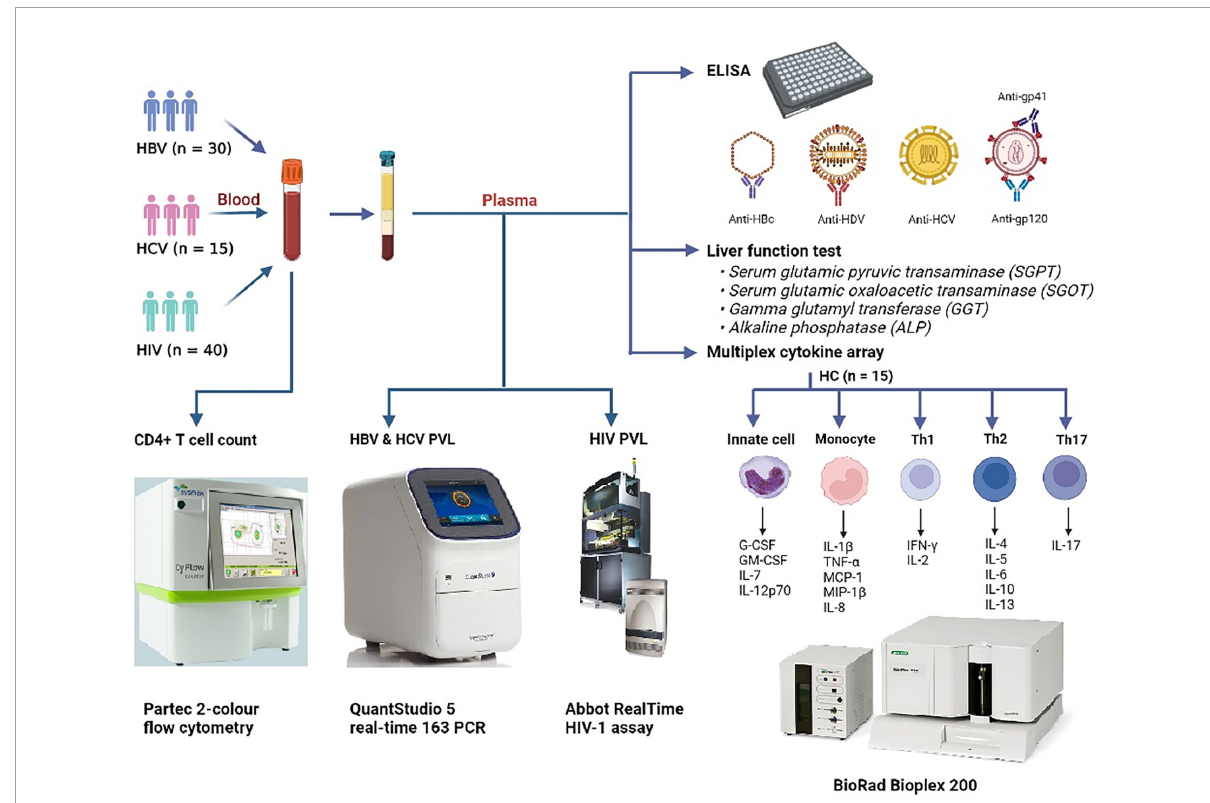
FIGURE1 Graphical outline of the study. Peripheral blood was collected from patients with HBV ( N = 30), HCV ( N = 15), and HIV ( N = 40) and were subjected to CD4+ T cell counts and HIV, HBV, and HCV viral load estimations. Anti-HBc IgG, anti-HDV IgM, anti-HCV, and anti-HIV-1/2 antibodies were screened by ELISA. Liver function test was performed to estimate the levels of SGPT, SGOT, GGT, and ALP in plasma. Plasma cytokine levels were determined by a commercial Bio-plex cytokine array. HBV, hepatitis B virus; HCV, hepatitis C virus; HDV, hepatitis delta virus; HIV, human immunodeficiency virus; HC, healthy control; SGOT, serum glutamic oxaloacetic transaminase; SGPT, serum glutamic-pyruvic transaminase; GGT, gamma-glutamyl transferase; ALP, alkaline